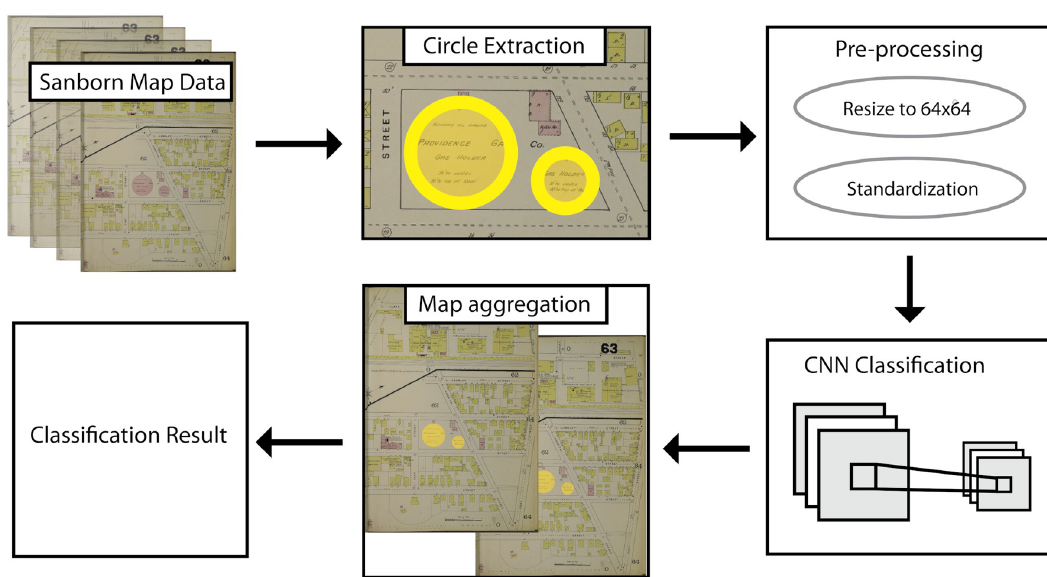
Fig 2. MGP identification workflow. Fig source: